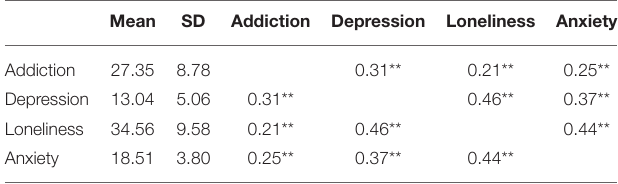
TABLE 1 | Descriptive results and zero-order correlations among the study